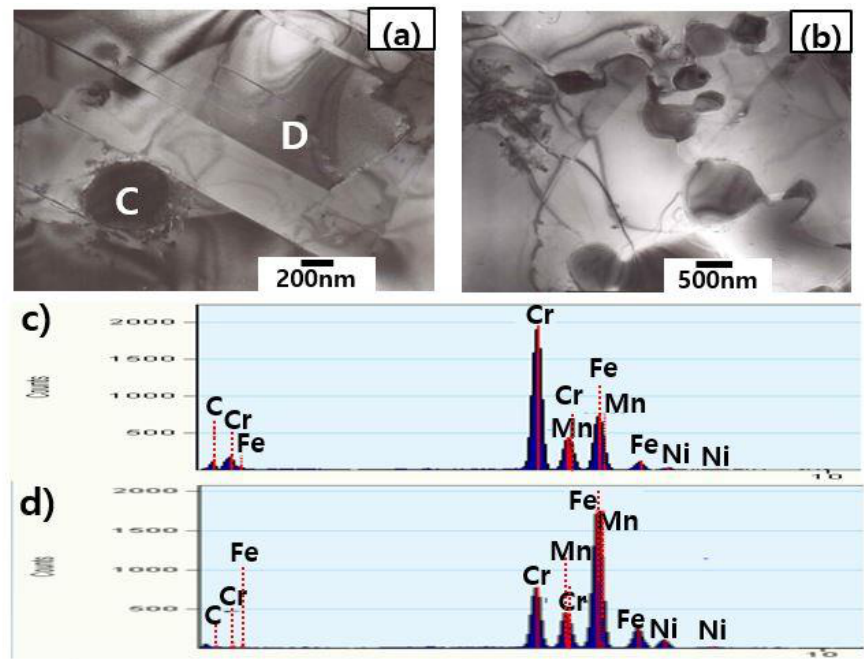
Figure 4. Microstructure (a) of groove-rolled rod, exhibiting equi-axed grains, and carbide particles, mostly at grain boundaries and XRD patterns ( b ) exhibiting the peaks from face-centered cubic (FCC) austenite and M 23 C 6 carbides.